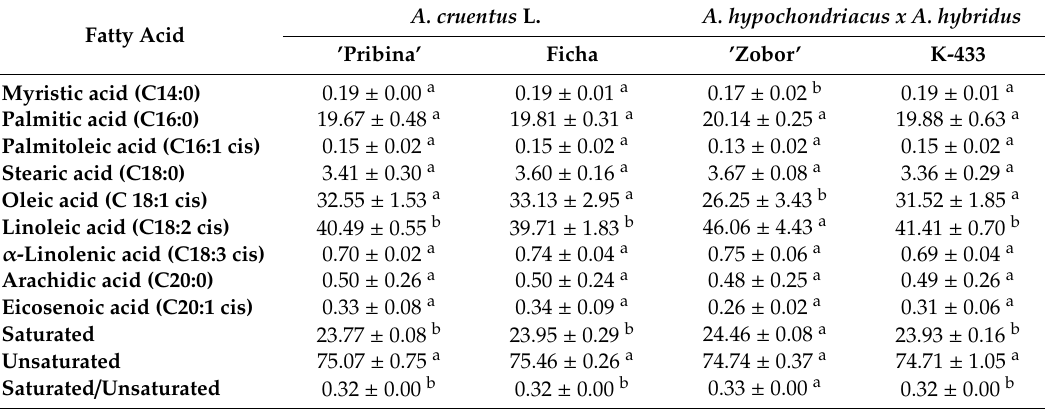
Table 4. Content of fatty acids in amaranth seeds